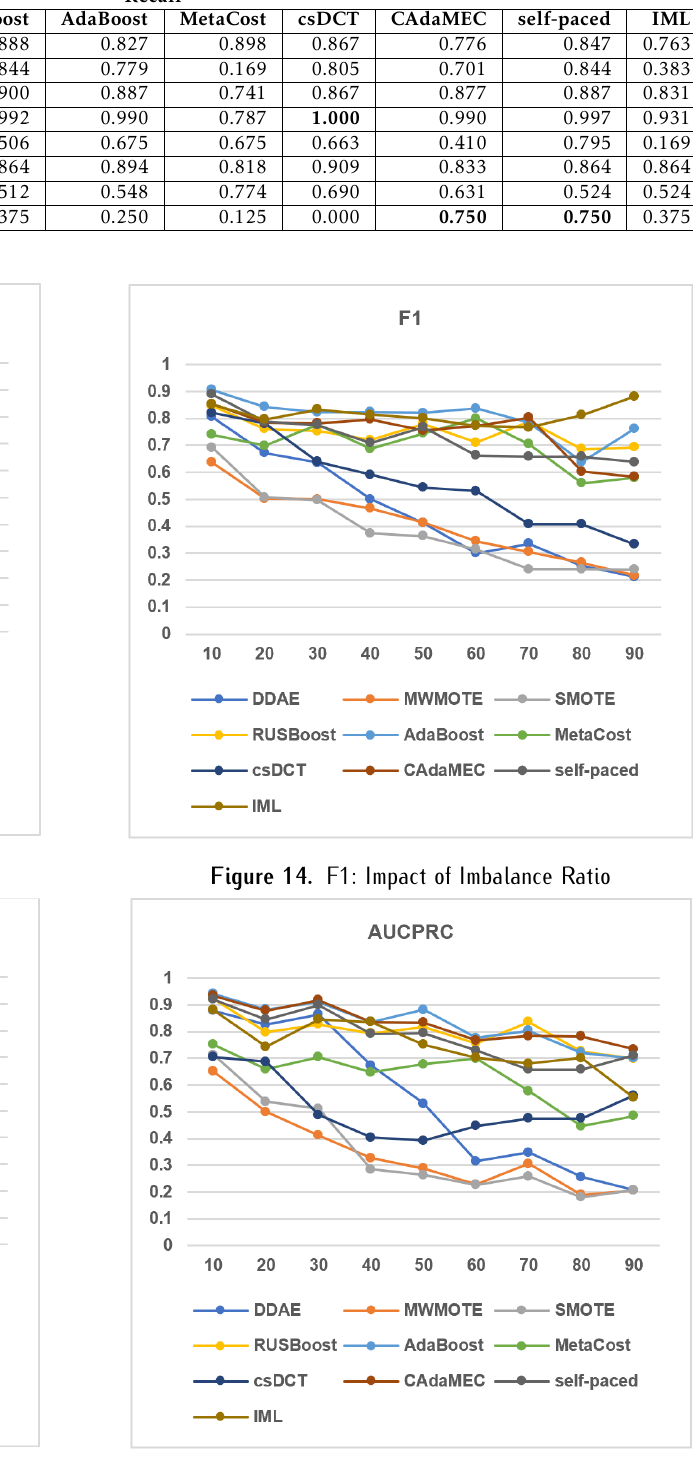
Figure 13. G-mean: Impact of Imbalance Ratio